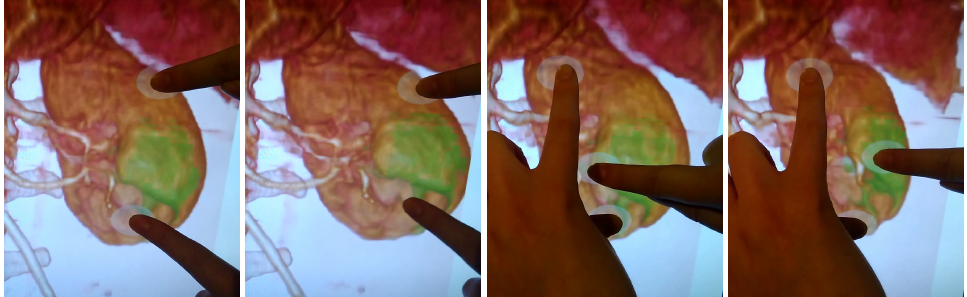
Figure 1. Intuitive manipulation and deformation of a kidney in a CT-scan. Our method allows users to directly touch and interact with anatomical elements in a medical volume image much like they would do in the real world, through natural manual actions. We use a rigid handle metaphor, highlighted in green in the images, to map user actions into the manipulation of the volume. The first two images show in-plane manipulation with two fingers, and the last two images show out-of-plane manipulation with three